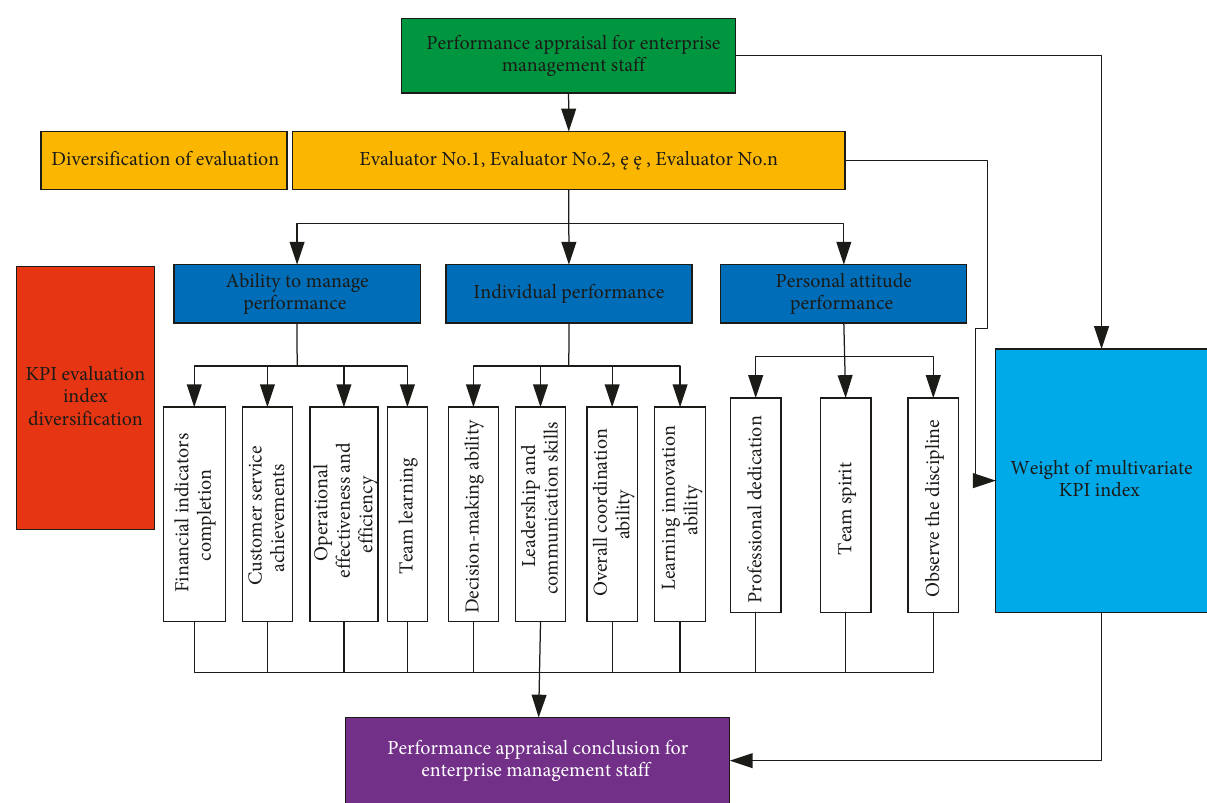
Figure 5: Flow diagram of the construction process of enterprise management employees’ performance appraisal system based on KPI. Table 1: The judgment matrix scale method.